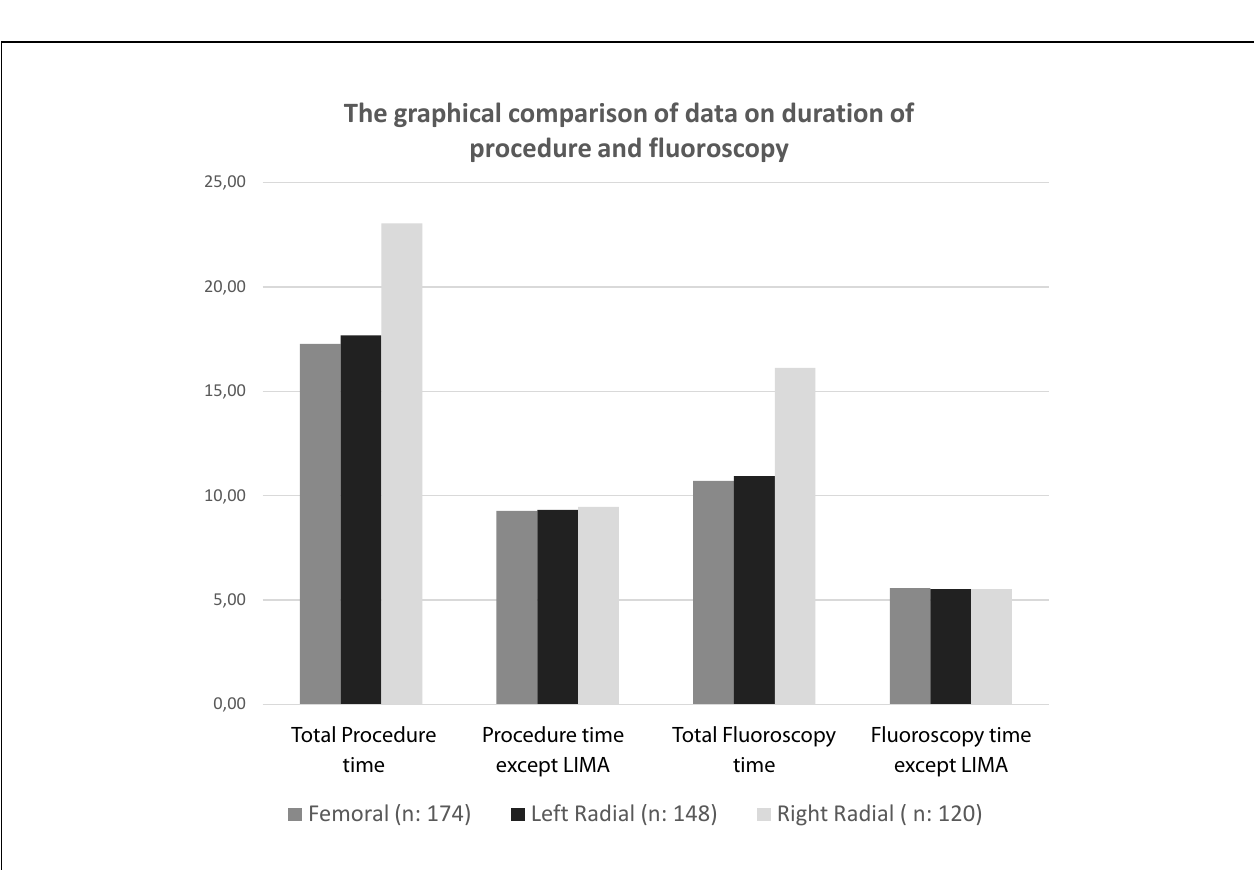
Fig. 4 – The graphical comparison of data on duration of procedure and